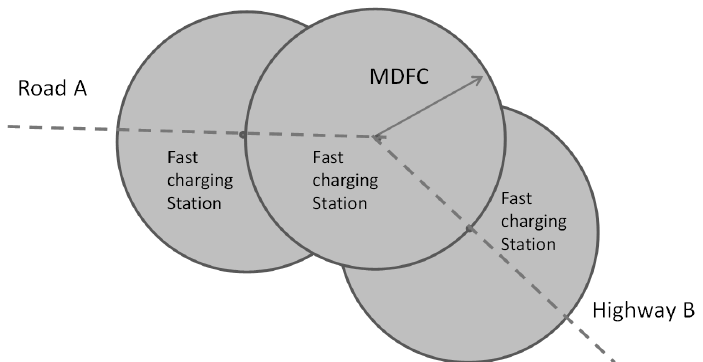
Figure 4. Range on highway infrastructure and